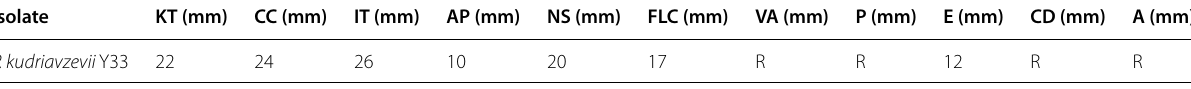
Ketoconazole (KT), clotrimazole (CC), itraconazole (IT), amphotericin-B (AP), nystatin (NS), fluconazole (FLC), vancomycin (VA), penicillin (P), erythromycin (E), clindamycin (CD), ampicillin